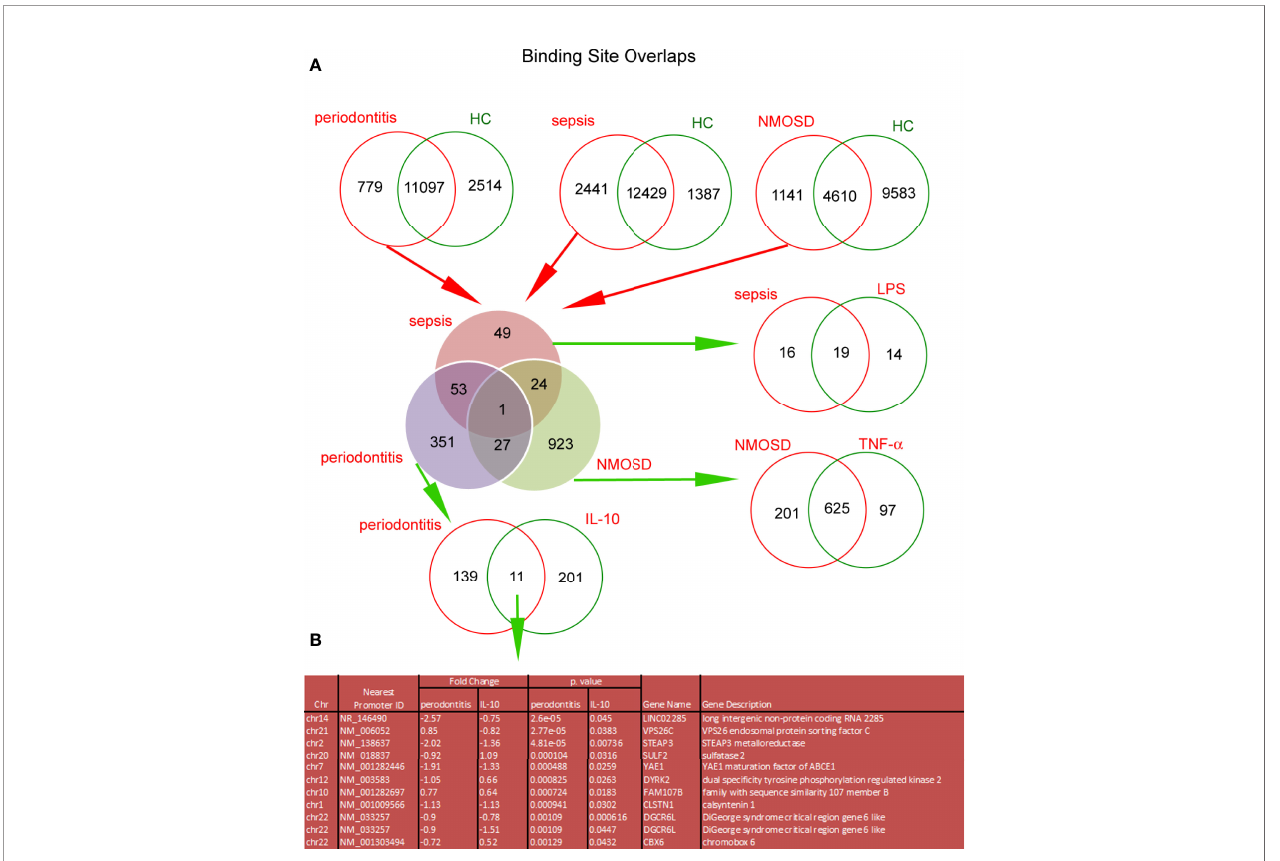
FIGURE 7 | The comparison of Binding Site Overlaps between in vitro model of neutrophil polarization and adequate clinic status. DNA binding sites within H3K4me3-marked histone in freshly isolated neutrophils from patients with sepsis, NMOSD, and periodontitis were juxtaposed with DNA binding sites associated with speci fi c activation in healthy volunteer neutrophils stimulated by LPS, TNF- a , or IL-10 for 5h, respectively. (A) The fi rst stage of comparison has indicated unique sites for each clinical condition. In the next step, the speci fi c binding sites have been narrowed down to those that occur selectively only in sepsis, NMOSD, or periodontitis - elimination of binding sites from each group as the result of neutrophil non-speci fi c activation regardless of the immune circumstances. In the last step of the analysis, the unique binding sites were compared with data obtained from in vitro model. Binding Site Overlaps graph was performed based on the average value of in vitro model (four independent experiments) and the average value of two independent adequate clinical cases. (B) Detailed summary table of high speci fi city binding sites with the highest statistical signi fi cance and the lowest FDR peaks which characterized polarization of neutrophils into immunosuppressive